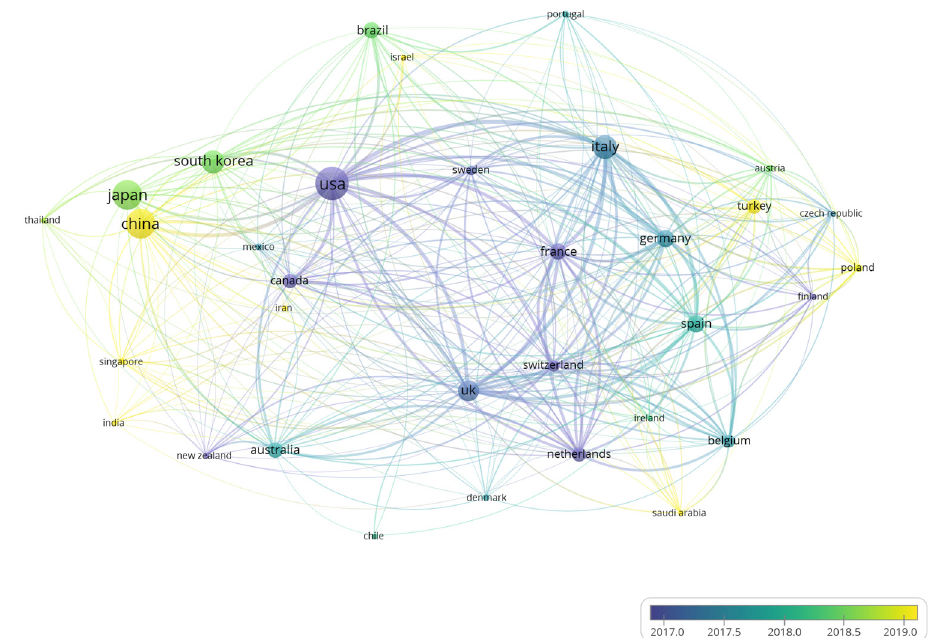
Figure 2. Coauthorship of 34 countries with at least 20 publications in sarcopenia. The size of nodes is determined by the publication numbers. The color indicates the average appearing year (AAY) and the thickness of the lines indicate the strength of the coauthorship.